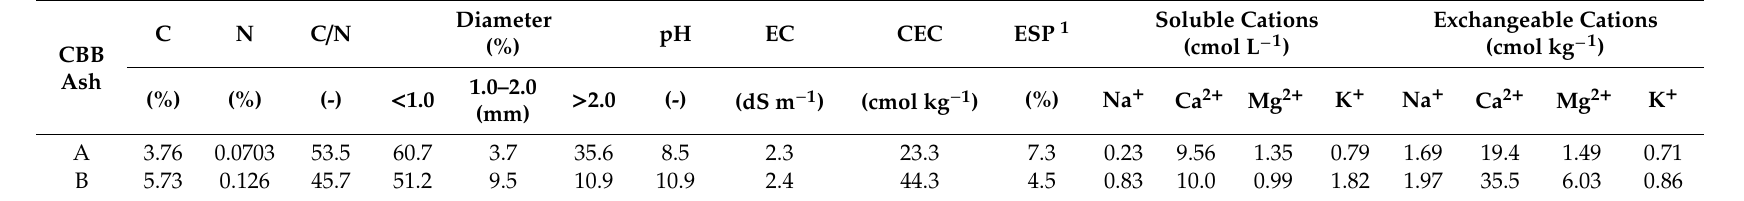
Table 4. Carbon and nitrogen content, and physicochemical properties of CBB ash A and